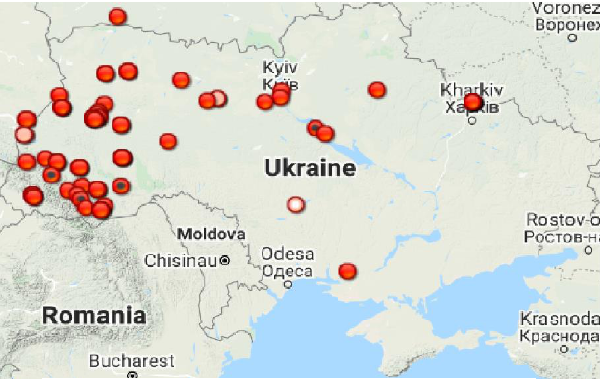
Fig. 3. Distribution of Caltha palustris in